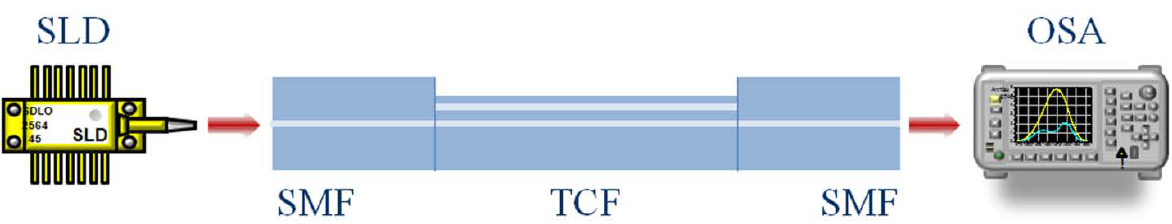
Figure 5. Schematic of the experimental setup for RI